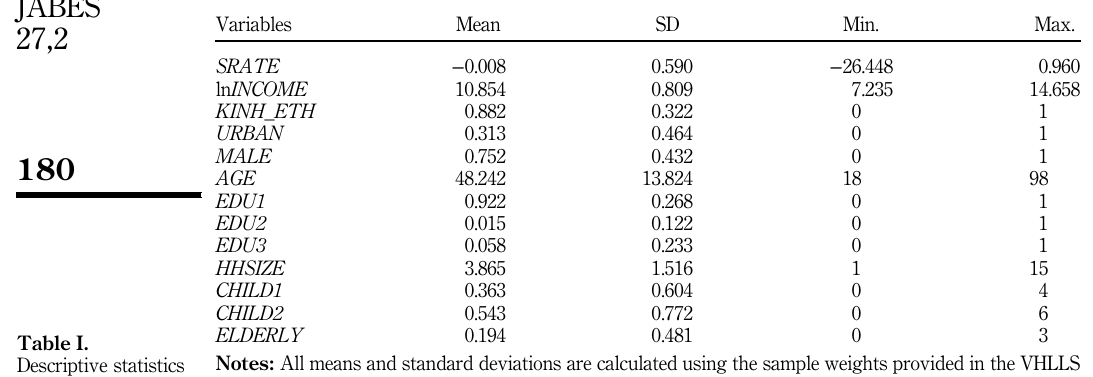
Table I. Descriptive statistics of the